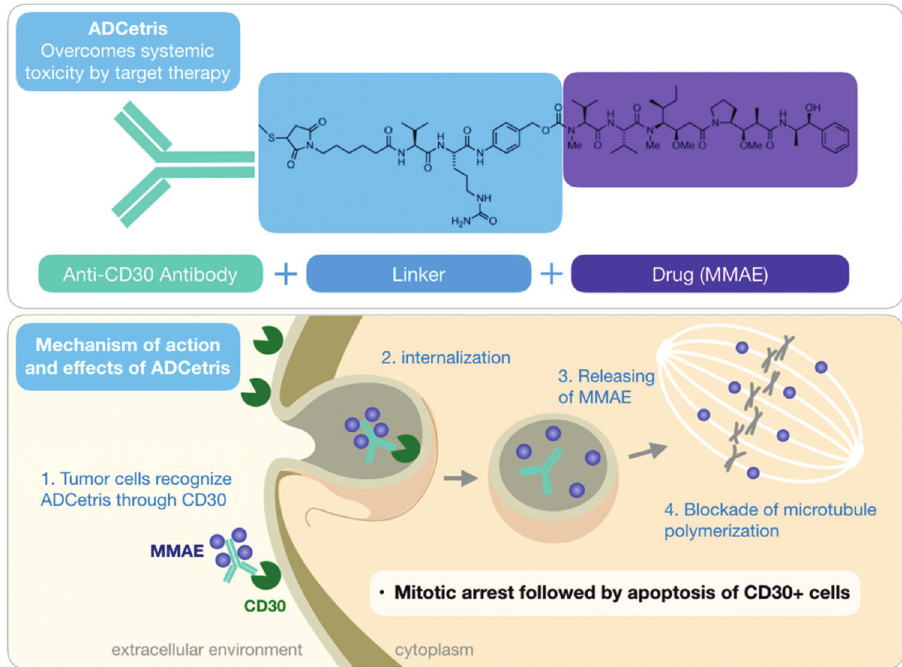
Figure 4 - Structure of brentuximab vedotin, an antibody-drug conjugate developed with the active principle monomethylauristatin E, a derivative of the natural product dolastatin 10 isolated from the mollusk Dolabella auricularia (top). A schematic representation of the mechanism of action of brentuximab vedotin in cancer cells expressing the CD30 antigen on the membrane